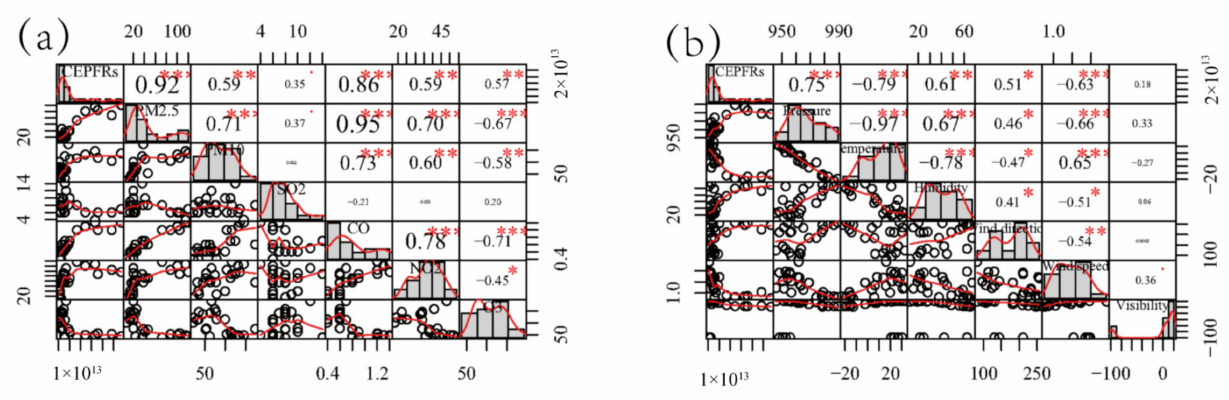
Figure 2. Pearson’s correlation coefficients for atmospheric concentrations of environmentally persis- tent free radicals and conventional pollutants ( a ) and meteorological variables ( b